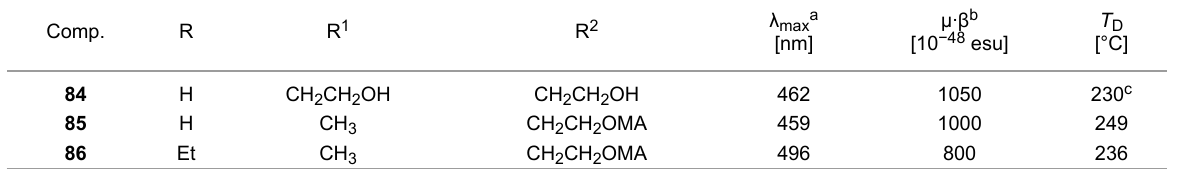
a Measured in DMF ( 84 ) and CHCl 3 ( 85 , 86 ); b measured in DMF by the EFISH technique at 1907 nm; c melting point.